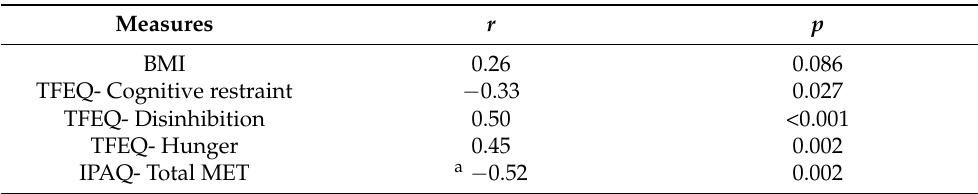
Table 2. Pearson correlation coefficient (r) for the relationship of overall 6P composite scores with BMI, TFEQ, and IPAQ ( n = 46).